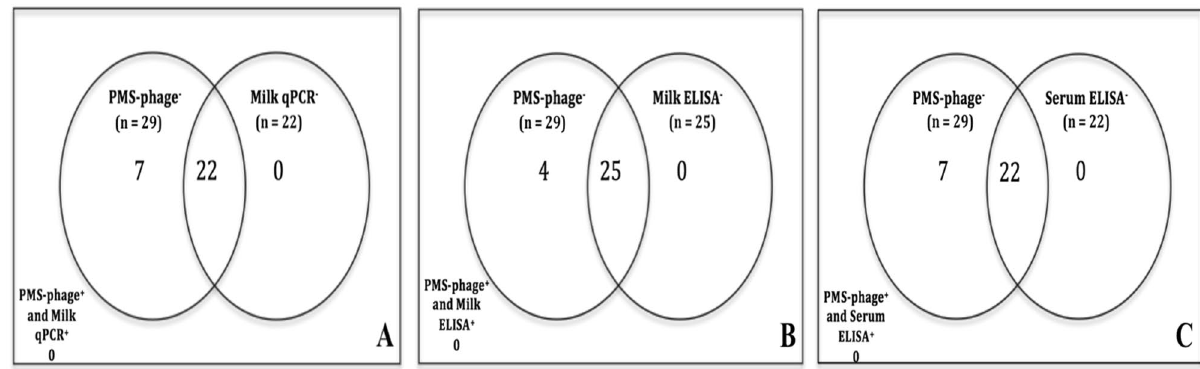
Figure 4. Venn comparison analysis between peptide mediated magnetic separation phage assay (PMS-phage) dataset and each MAP diagnostic assay of milk qPCR ( A ), milk ELISA ( B ), and serum ELISA ( C